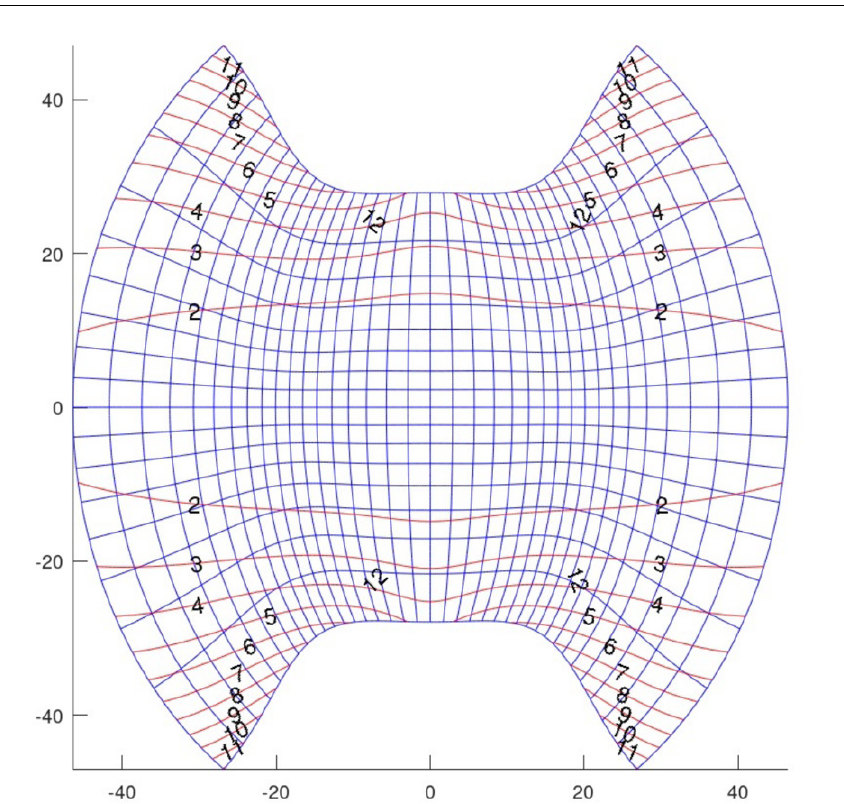
Fig. 15. The cartographic grid and the distribution of distortions in the projection created with the use z of the function 3 sin